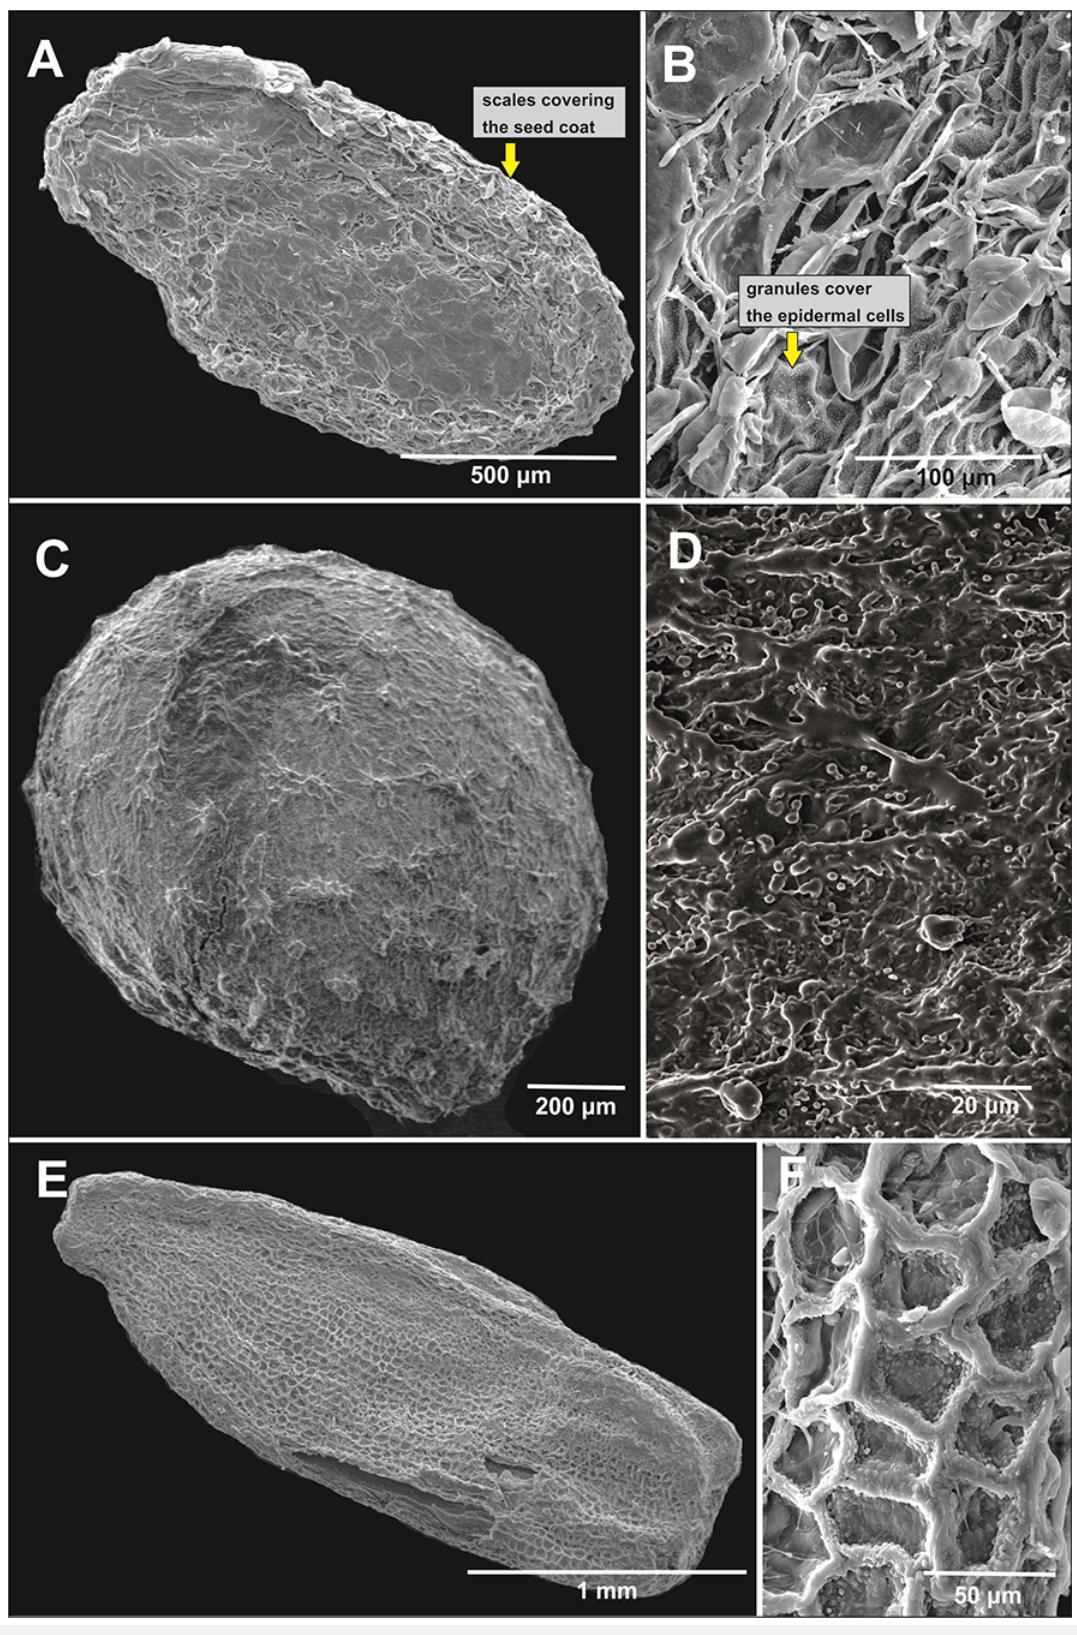
Figure 2 Seed general view and coat micromorphology of analyzed balsams from Northeast India. ( A,B ) Protrusive type: Impatiens anjawensis ; ( C,D ) granulate type: I. jurpia ; ( E,F ) reticulate type: I. nyimana .